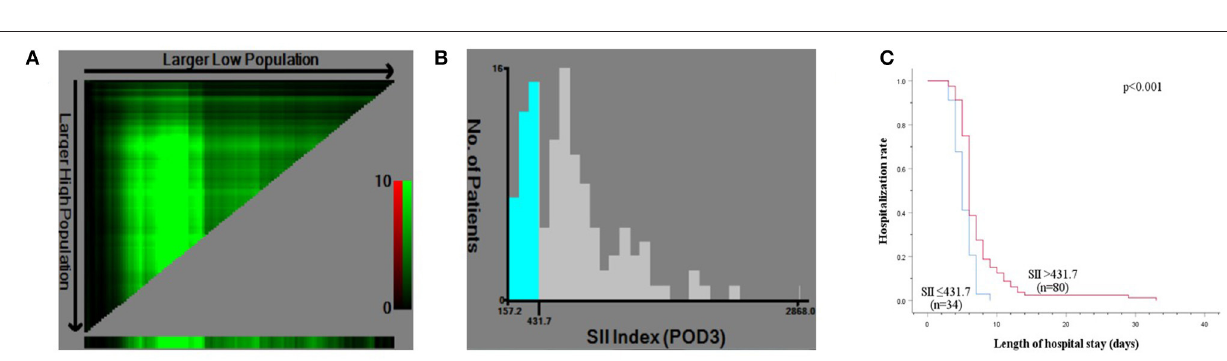
FIGURE 3 | X-tile analysis for calculating the cutoff point of SII on postoperative day (POD) 3. (A) X-tile plot of SII on POD 3. (B) The optimal cutoff point shown on a histogram of entire cohort. (C) Kaplan–Meier plot of association between SII ≤ 431.7 and hospitalization